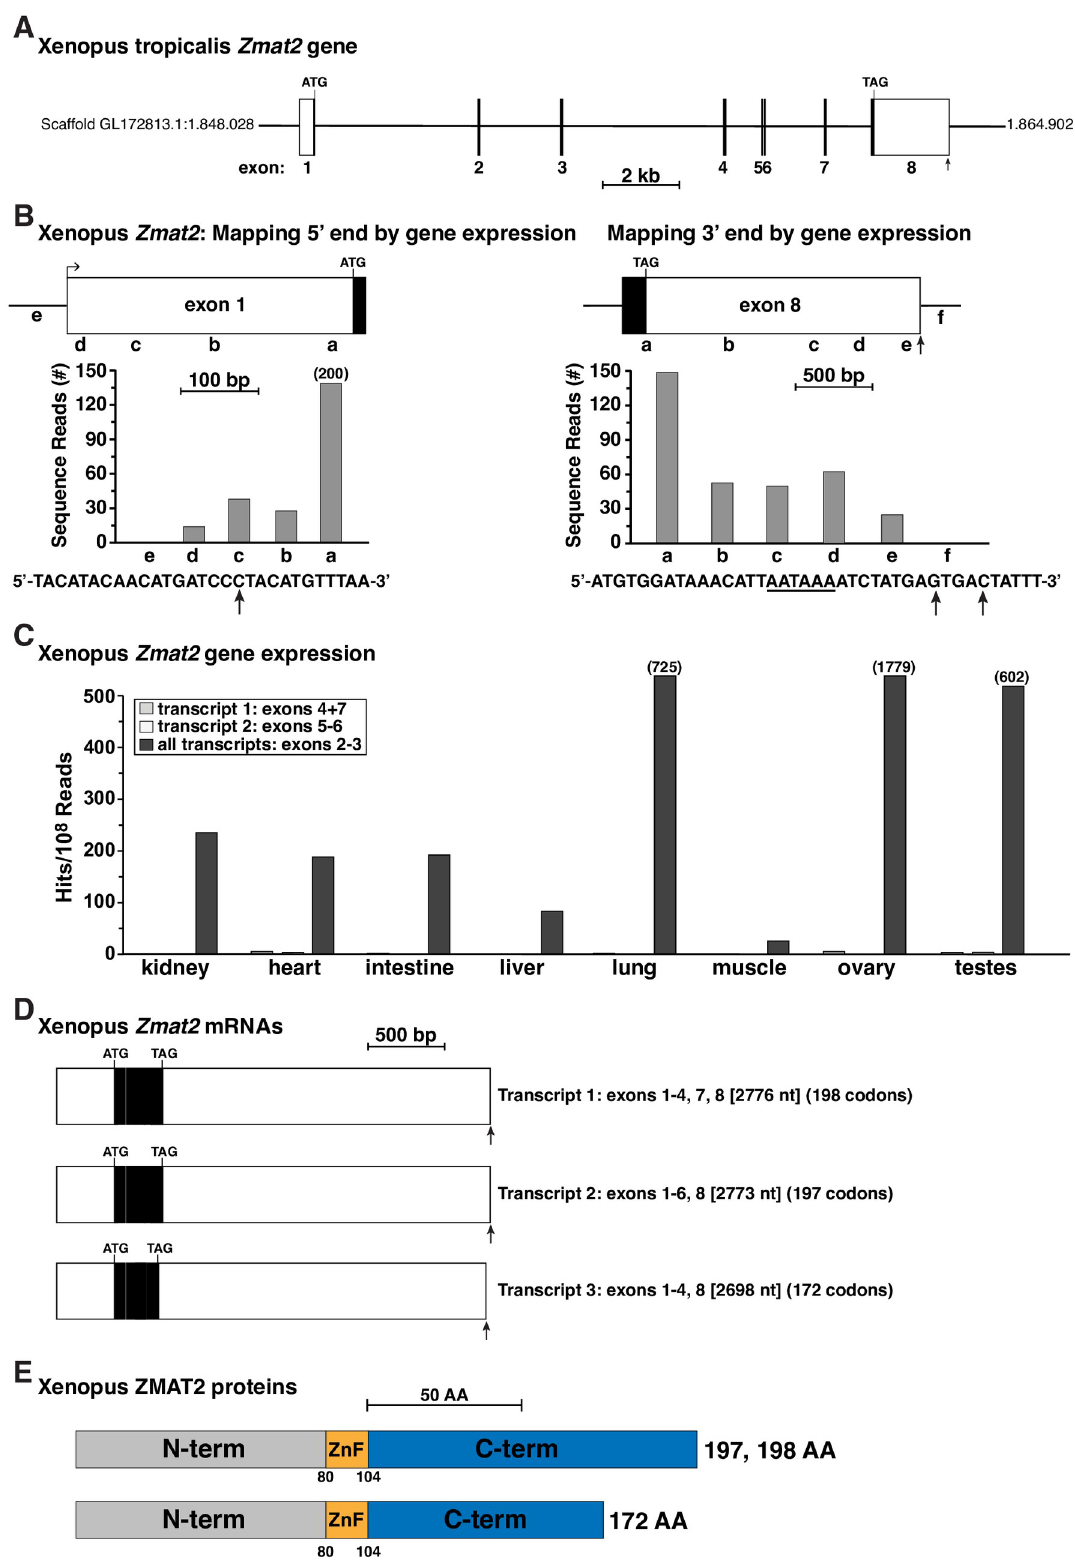
Fig 3. The Xenopus tropicalis Zmat2 gene is more complicated than in other terrestrial vertebrates. A . Diagram of the Xenopus tropicalis Zmat2 gene. Exons are depicted as boxes, with coding segments solid and noncoding regions white. The 5’ end of exon 1 and the 3’ end of exon 8 were defined in B . The locations of ATG and TAG codons are indicated, and a scale bar is shown. B . Mapping the